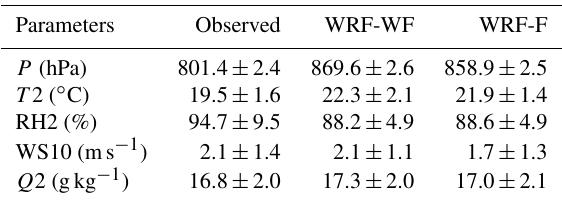
Table 2. Comparison of the simulated meteorology for surface pres- wind speed (WS10), and 2m specific humidity ( Q 2) to the obser- vations in the outermost domain d01 for two model simulations: WRF-WF and